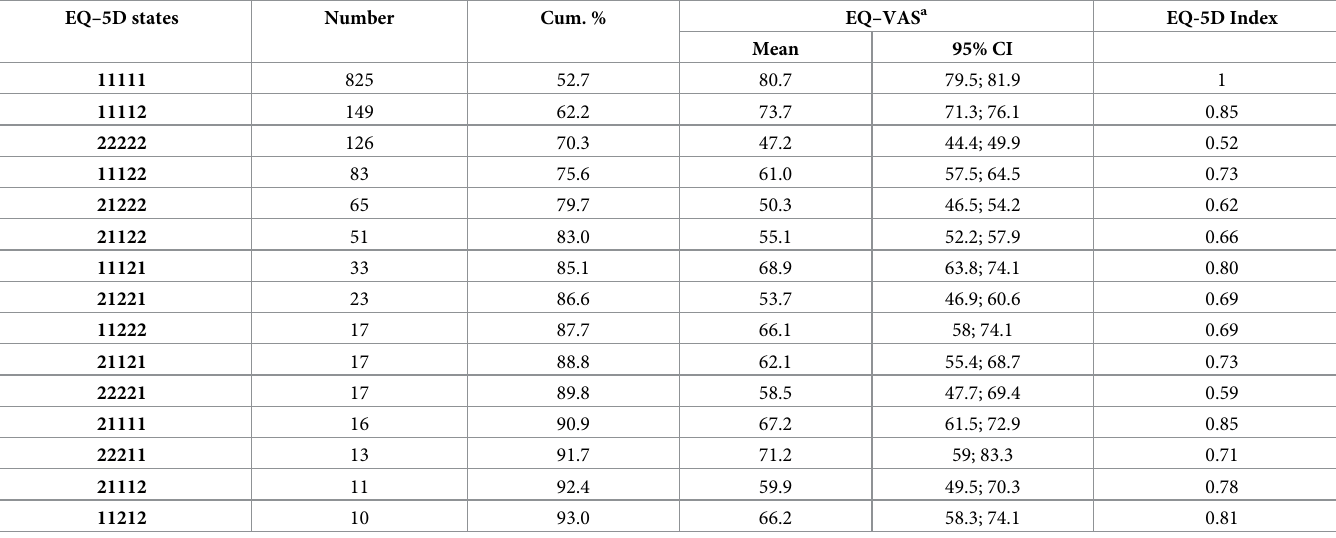
Table 5. Most frequent health states with mean EQ–VAS and utility